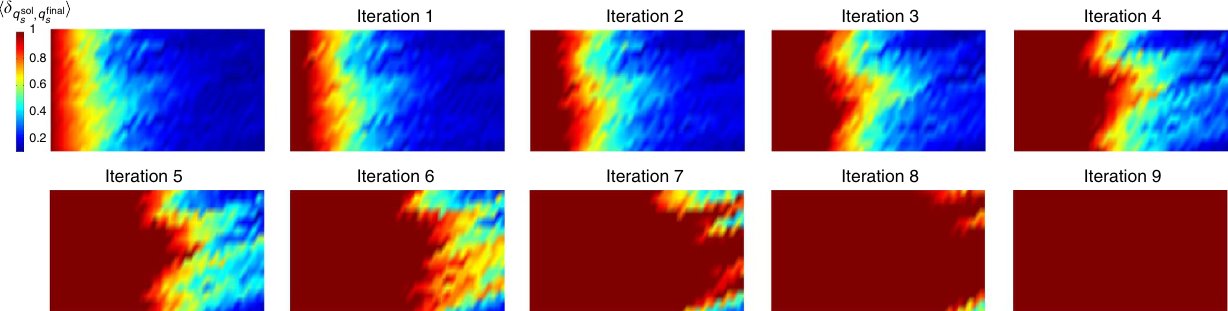
Figure 7 | Growing correlation length with learning for fixed-input boundary condition. Annealing with learning for the fixed-input boundary case for a system of size 16 (cid:4) 42 with 20% TOFFOLI gates. The annealing time within each iteration is t a ¼ 2 13 and the gate state probability threshold a ¼ 0.7.